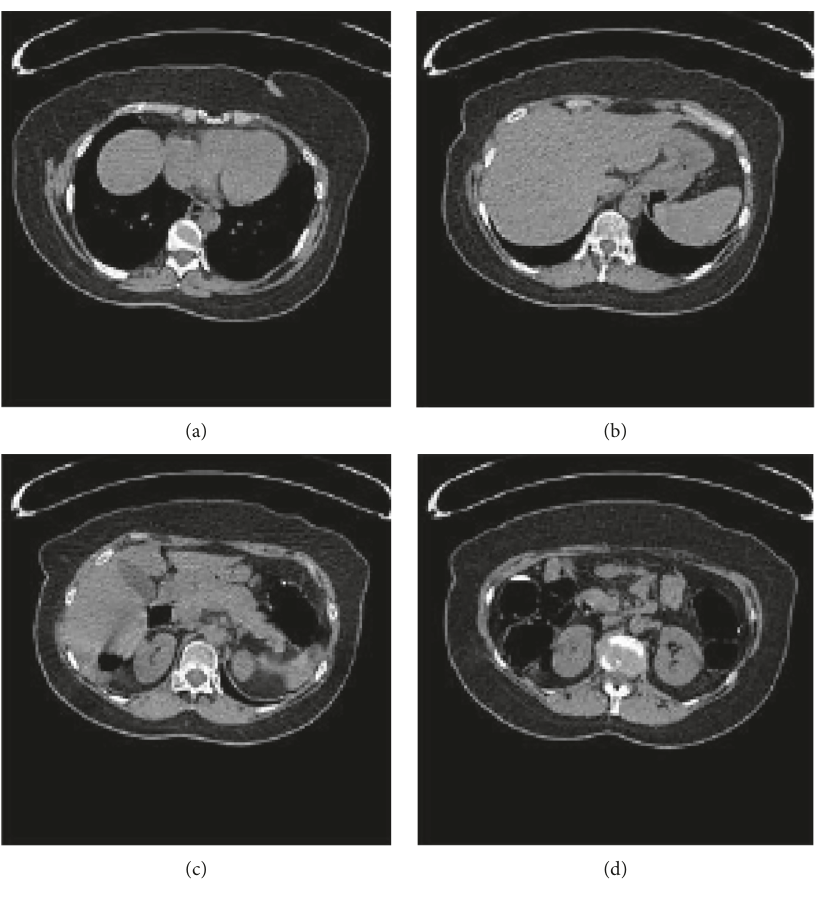
Figure 5: Examples from the TCIA-CT database.